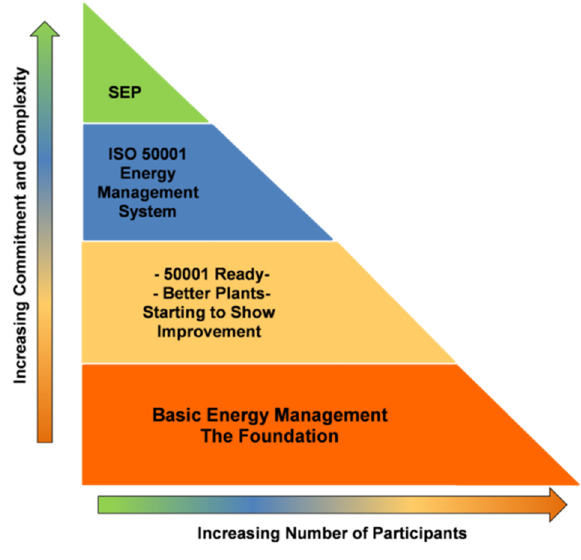
Figure 4. Strategic energy management continuum [28].